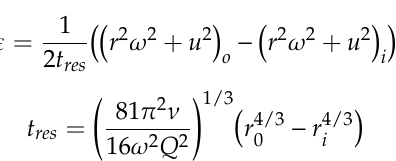
Figure 13. Z-average sizes for 2% w / v and 4% w / v starch highlighting the effect of ( A ) flow rate at 9:1 ratio and 1200 rpm, ( B ) disc speed at 9:1 ratio and 18 mL/s, and ( C ) antisolvent to solvent ratio at 18 mL/s and 1200 rpm.